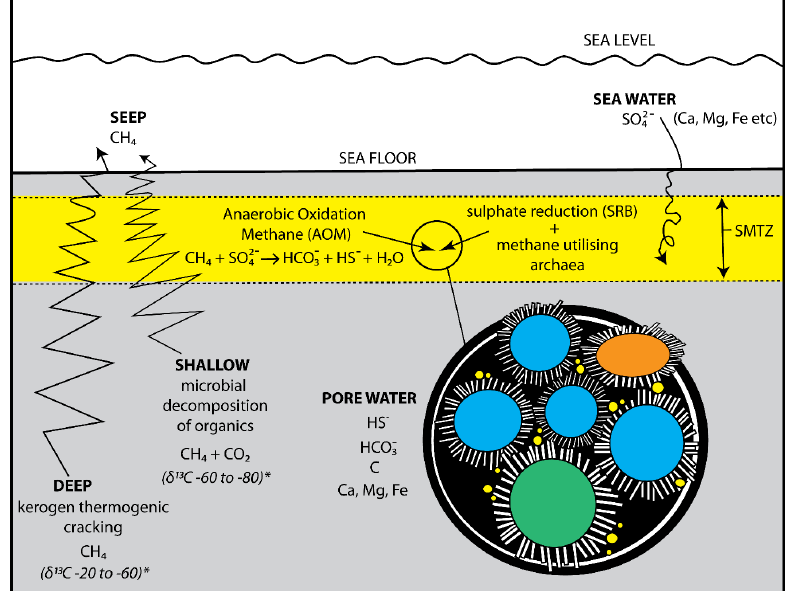
Figure 1. Processes involved in the formation of methane-derived authigenic carbonate (MDAC) and pyrites. Note δ 13 C values for methane source from [1], * Vigneron et al. [16] put the boundary between thermogenic and microbial methane generation at −50 ∂ 13 C. Blue = quartz grains, orange = carbonate grains, green = feldspar grains, yellow = pyrite framboids, white = acicular aragonite. SMTZ = Sulphate-Methane Transition Zone.